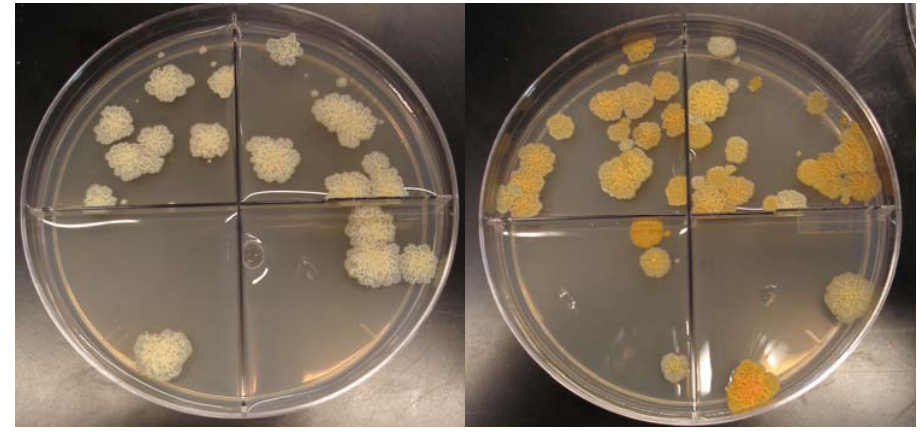
Figure 3. M. smegmatis colony forming units of (a) wild-type non-spray dried bacteria and (b) multiply-cycled bacteria after 1 day exposure to light and air. Bacteria are not exposed to light during incubation. The orange phenotype will emerge in the wild-type strain after exposure to air and light at low frequency. Multiply-cycled bacteria emerge from the incubator with the orange phenotype which becomes more intense upon exposure to light and